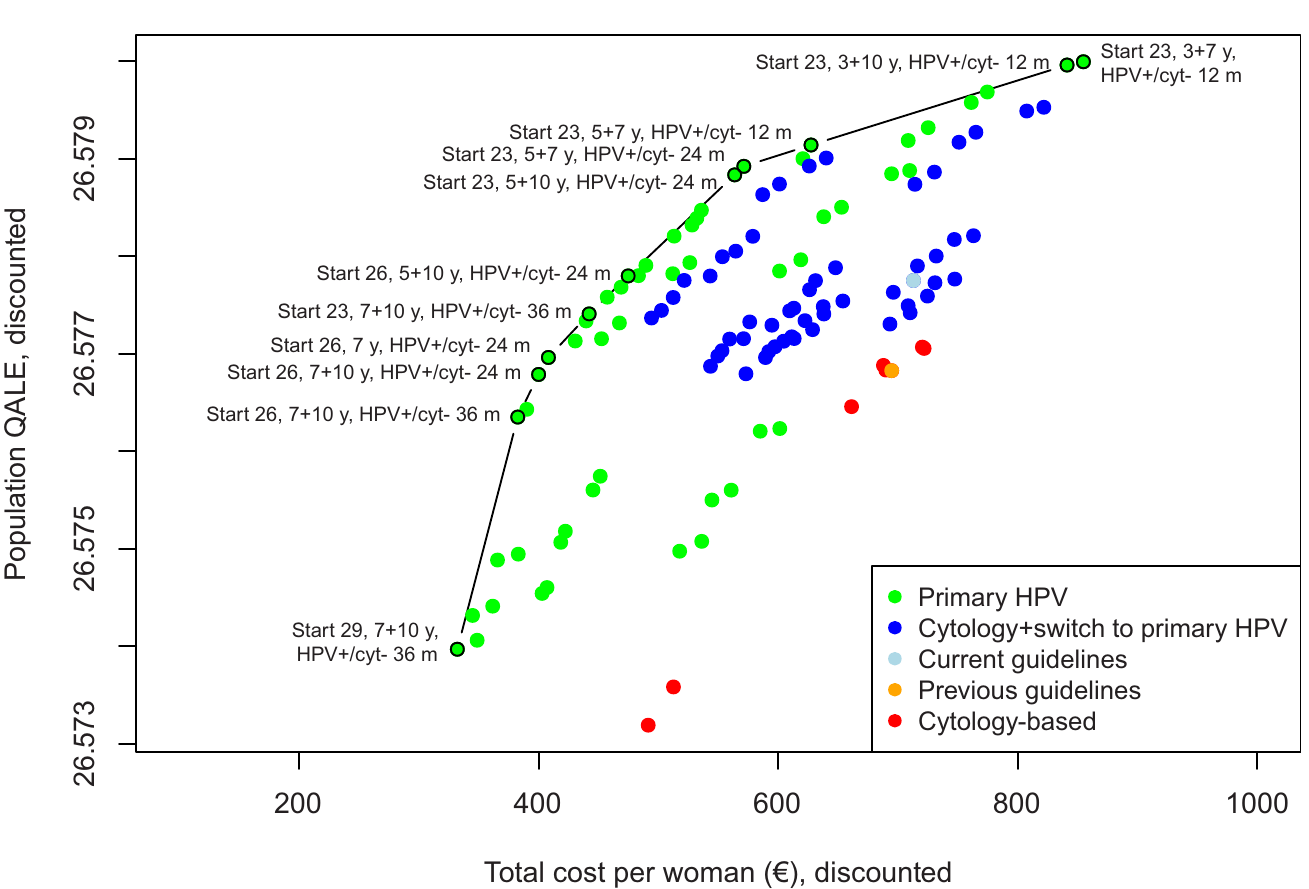
Fig 2. Discounted (3%) cost-effectiveness of 116 screening strategies under the baseline assumptions, including the 11 strategies on the cost-effectiveness efficiency frontier (black circles). The no screening strategy (natural history) has been excluded from the graph. Strategy nomenclature: “Start” indicates screening start age, y indicates years (before and after age switch), and human papillomavirus (HPV)+/cyt- m indicates the follow-up time for HPV-positive, cytology negative women (in months).